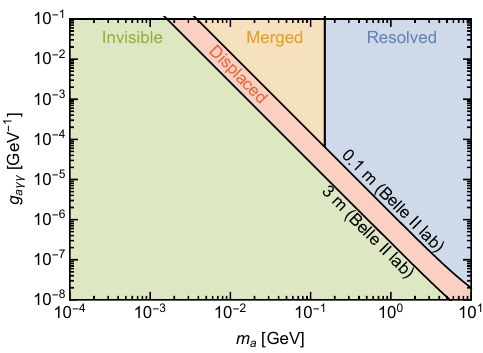
Figure 5 . Illustration of the di(cid:11)erent kinematic regimes relevant for ALP decays into two photons with Belle